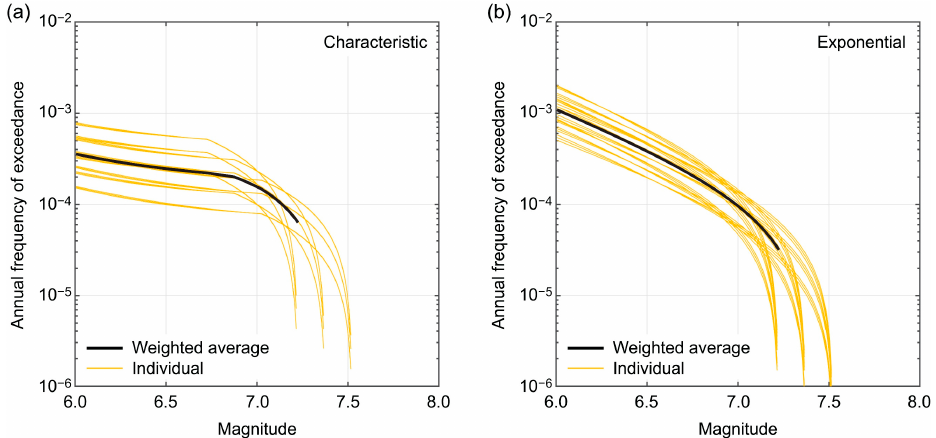
Figure 3. Magnitude–recurrence relationships for the Leech River Valley Fault based on the charac- teristic model ( a ) and the truncated exponential model ( b ). For each magnitude model, 27 variations were considered by assigning discrete values to slip rate, b value, and M max .